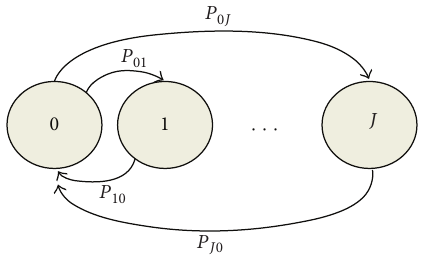
F 2: State model for each user in the network.